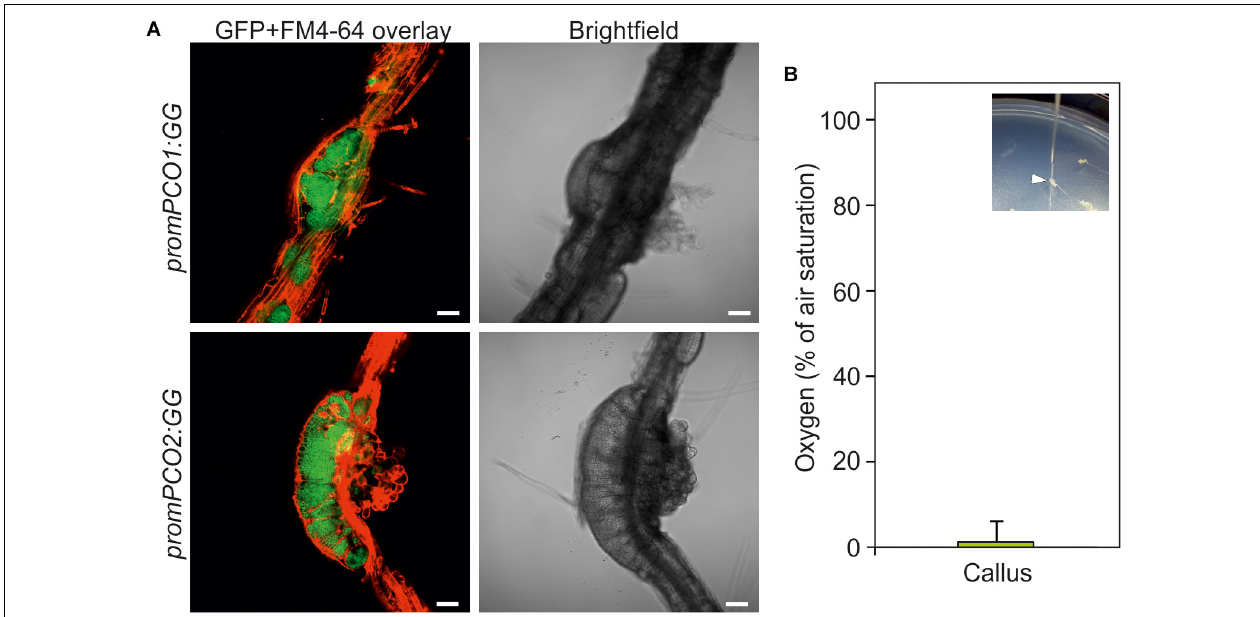
FIGURE 7 | Callus is hypoxic. (A) GUS activity of promPCO1:GG and promPCO2:GG hypoxia-signaling reporters in root-derived calli. GFP fluorescence of promPCO1:GG and promPCO2:GG in calli. FM4-64 was used to stain the cell membranes. Scale bars, 50 µ m. (B) Direct oxygen measurements in callus using an oxygen microsensor (% of air saturation). The inlet shows insertion of the microsensor into a